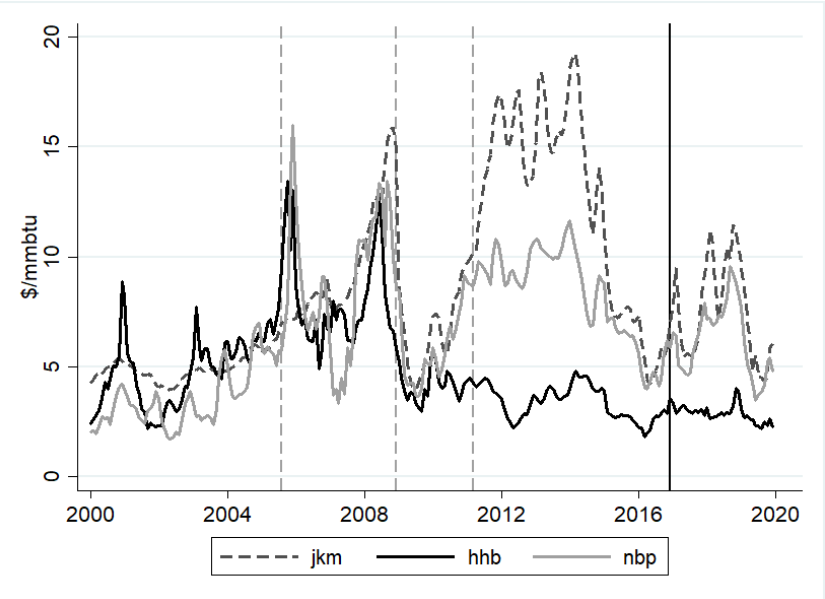
Figure 2. Plot of JKM (Asia), HHB (North America) and NBP (Europe) natural gas prices. Note: HHB = Henry Hub natural gas price (North America), NBP = National Balancing Point natural gas price (Europe) and JKM = Japan Korea Marker (Asian). Dotted vertical lines indicate the potential structural break points and a solid vertical line indicates the end of sample period